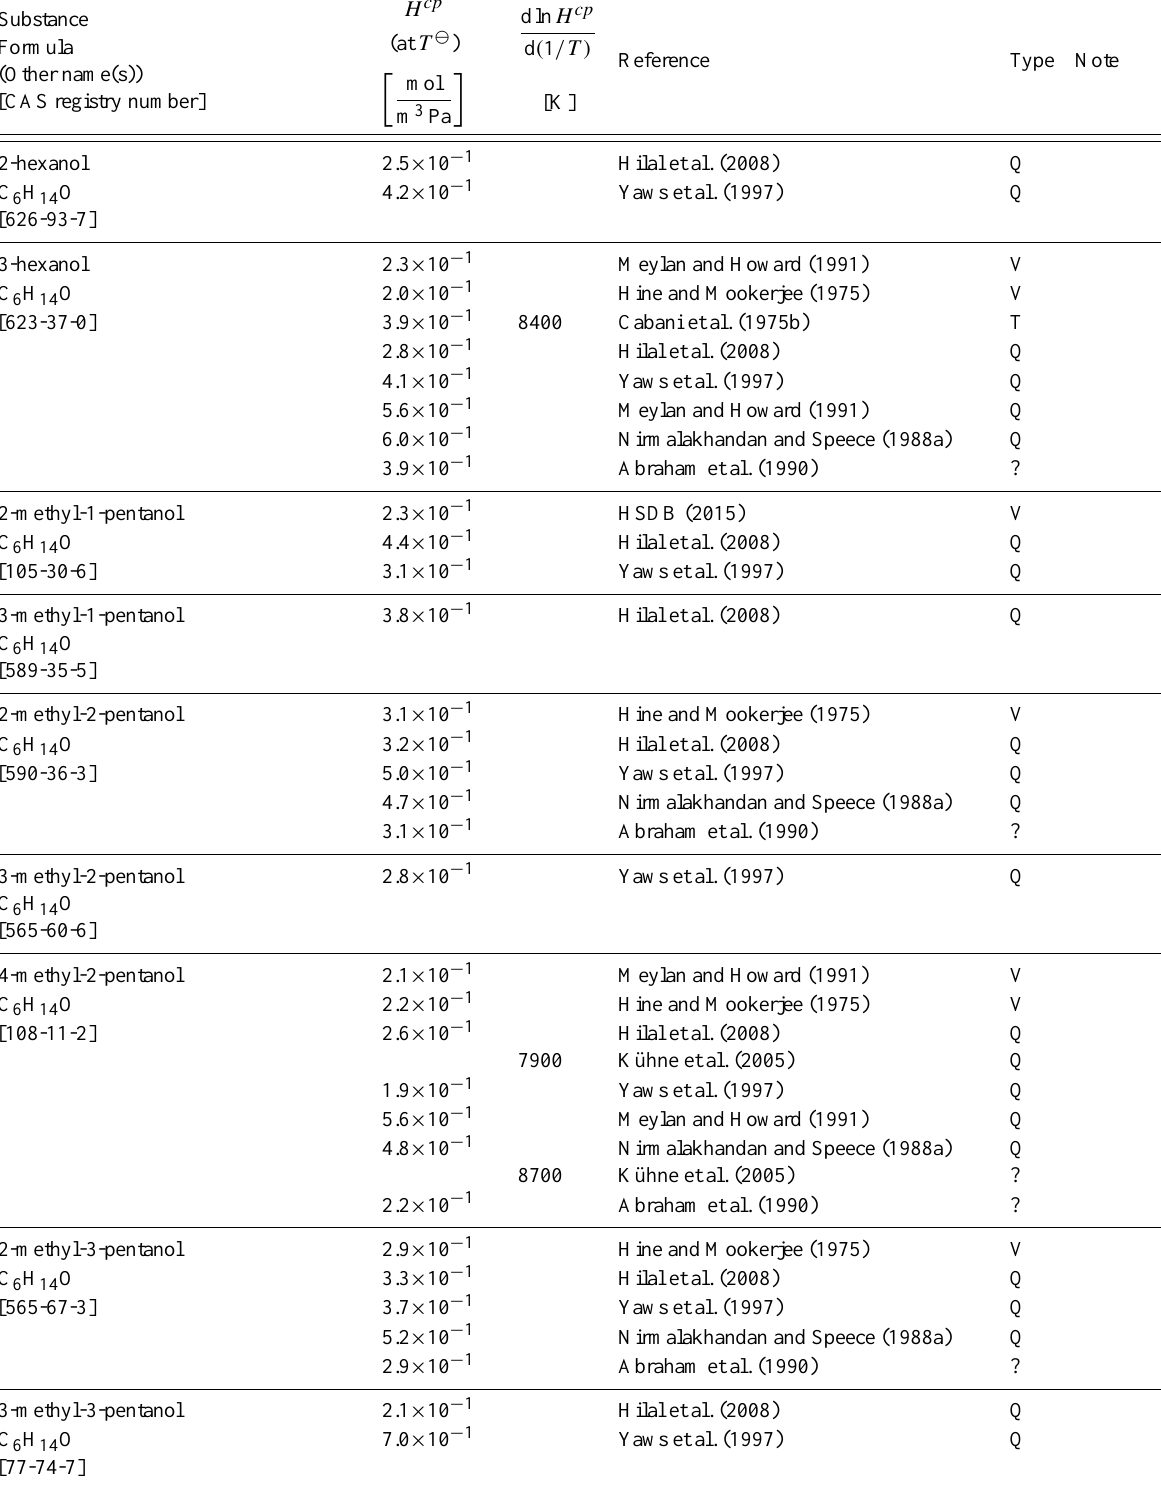
Table 6: Henry’s law constants for water as solvent